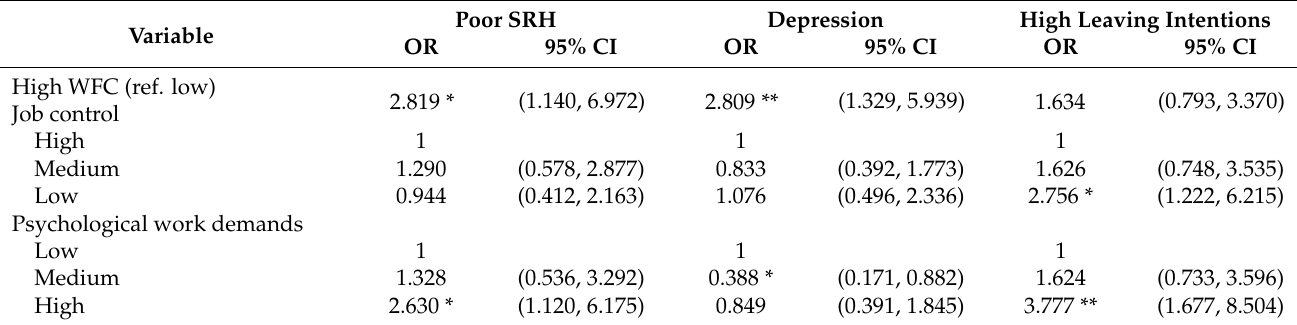
Table 3 shows the results of the multivariate logistic regression analysis of three health outcomes and leaving intentions. The findings of the regression models indicated that a high level of WFC was a significant predictor of poor self-rated health (odds ratio (OR) = 2.819) and depression (OR = 2.809), but not of high leaving intentions, even after adjusting for age, educational level, and adverse psychosocial work factors. Table 3. Odds ratio (OR) for poor self-rated health (SRH), depression, and high leaving intentions of nurses ( N = 200).